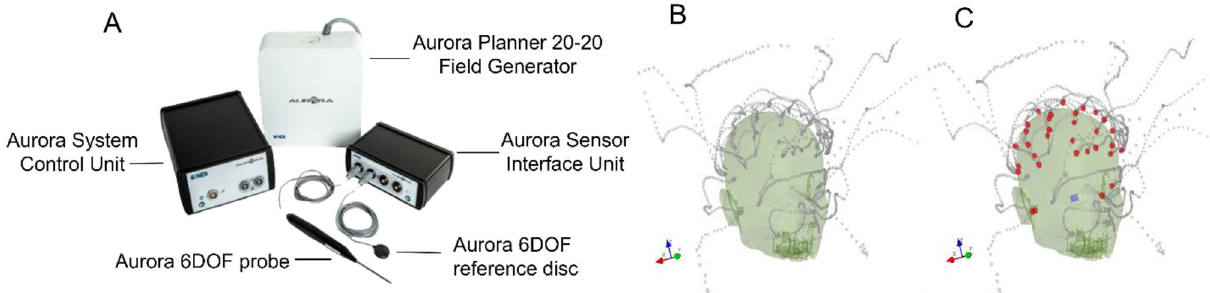
Figure 3. Aurora system. ( A ) Components used for the study (image courtesy to NDI, Waterloo, ON, Canada), ( B ) clustered continuous tracking points (grey points). ( C ) The digitization points (red); both in MEGIN’s head coordinate system.